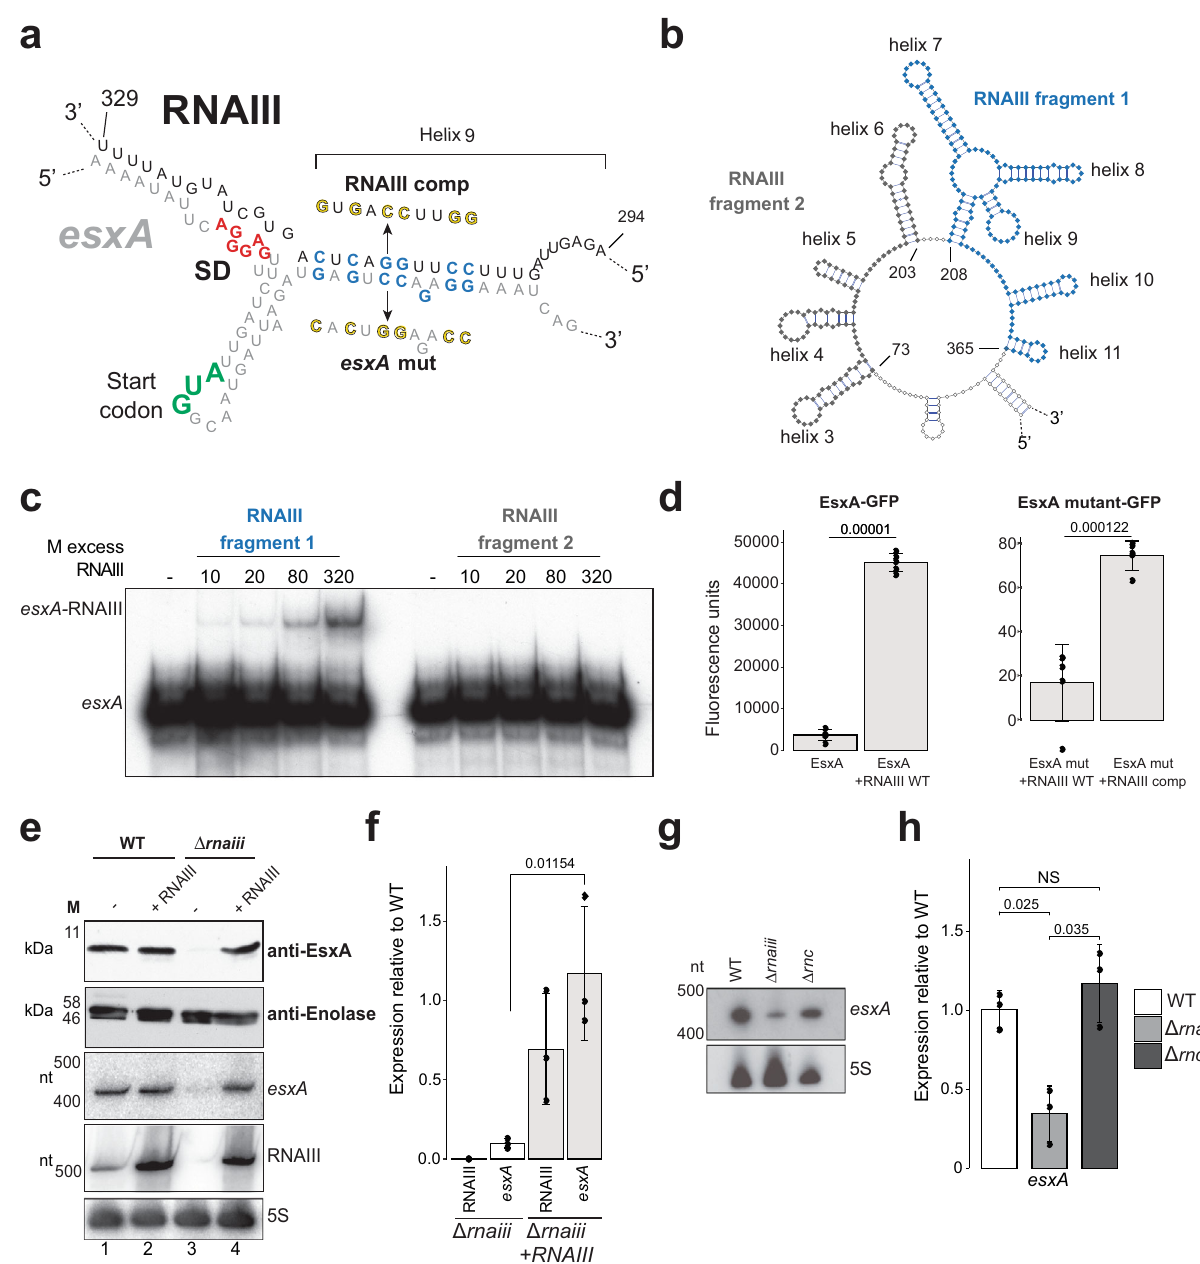
Fig. 7 RNAIII base-pairing with the esxA mRNA is required for EsxA production. a Predicted base-pairing interactions between RNAIII and esxA as found through CLASH. Green text: translational start codon; red text: Shine-Dalgarno (SD) sequence, blue text: nucleotides that were mutated (yellow) to generate the seed and the compensatory mutants. b Secondary structure of the region containing RNAIII fragments 1 (blue) and 2 (dark grey) that were used for in vitro binding assays. c EMSA between radiolabelled esxA and RNAIII fragment 1 (blue text; containing helix 9) and RNAIII fragment 2 (grey text). Results from a single experiment is shown. d In vivo GFP-fusion reporter assay 76 . A portion of the 5 ʹ UTR and CDS of esxA was fused to sfGFP and expressed in RN4220. FACS was used to measure GFP fl uorescence of WT and esxA seed mutant upon RNAIII overexpression. “ RNAIII comp ” : mutant predicted to base-pair with the esxA seed mutant. Shown are the averages and standard deviations for fi ve independent biological replicate experiments. Values above bars display p -value (mutant vs WT; student ’ s two-tailed, unpaired t test). e Stability of EsxA protein and mRNA upon RNAIII deletion and restoration. The Eno1 protein signal was used as a loading control. Northern blotting was performed to detect esxA , RNAIII and 5 S rRNA levels. Shown are representative results from three independent experiments. Statistical signi fi cance was measured through Student ’ s unpaired, two-tailed t test. f Quanti fi cation of the results in e . Shown are averages and standard deviations. Values above bars display p value (mutant vs WT; student ’ s two-tailed, unpaired t test). g Stability of esxA mRNA upon deletion of RNase III. Shown are northern blot results from one of three independent biological replicate RNA samples that were analysed by RT-qPCR ( h ). h Expression of esxA in WT, RNAIII and RNaseIII mutants. Shown are the mean and standard deviation of three independent biological replicates. Values above bars display p values (mutant vs WT) obtained using Student ’ s two-tailed, unpaired t test. Strains tested: WT (white), Δ rnaiii (light grey) and Δ rnc (dark grey). Raw images and data used to generate ( c – h ) are provided in the Source Data fi